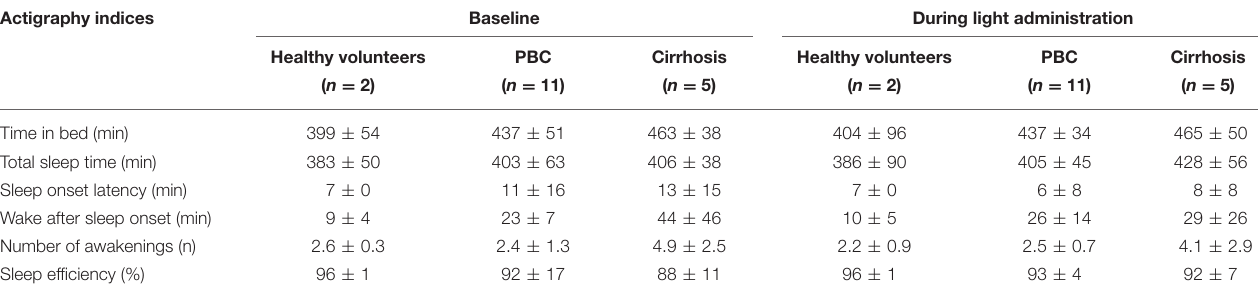
TABLE 2 | Actigraphic sleep-wake indices (mean ± SD), by group and in relation to treatment. Actigraphy indices Baseline During light administration